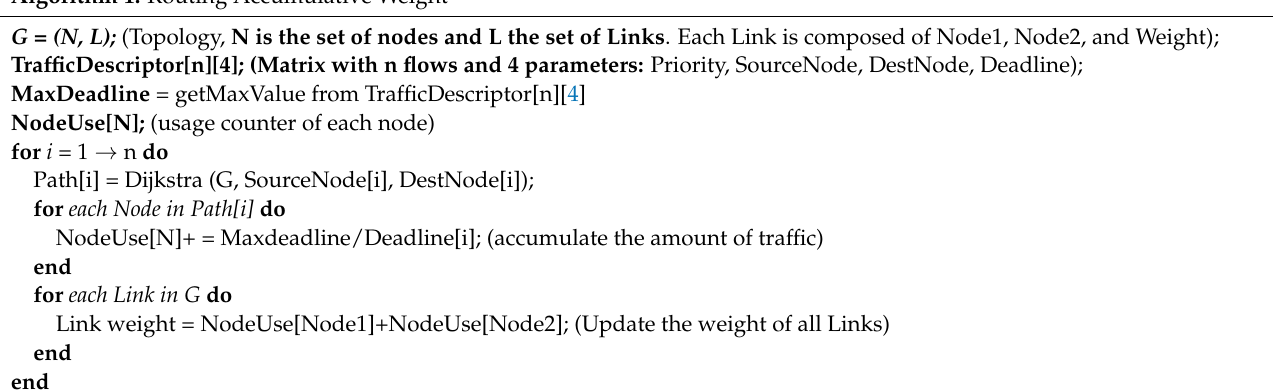
Algorithm 1: Routing Accumulative